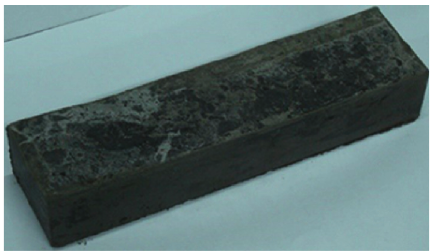
Figure 2: Molding sample.